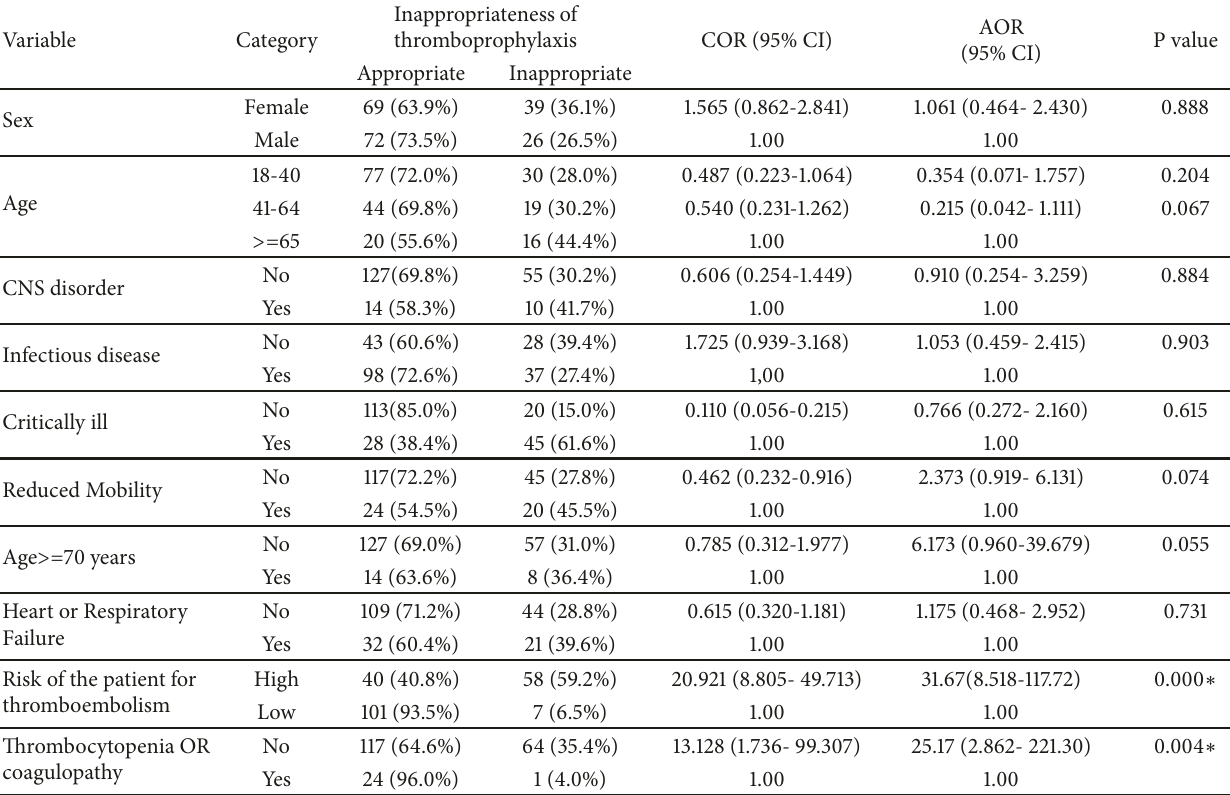
Table 5: Factors associated with inappropriateness of